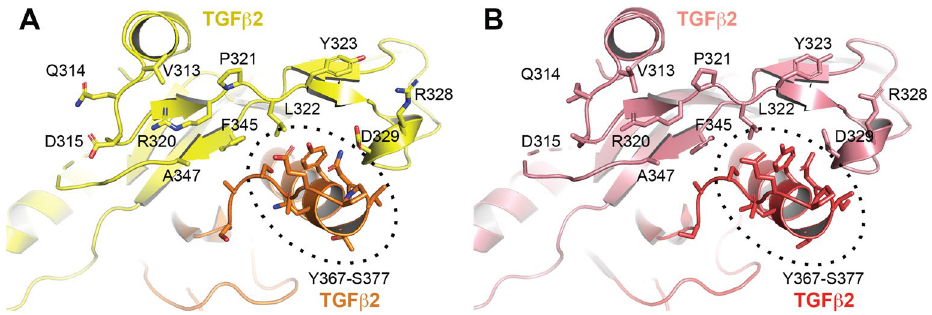
Figure 3. The epitopes of h4A11.v2 and h4A11.v7 on TGFβ2 are identical. The residues in TGFb2 dimer that form the epitopes of ( A ) h4A11.v2 and ( B ) h4A11.v7 are highlighted as sticks and labelled.